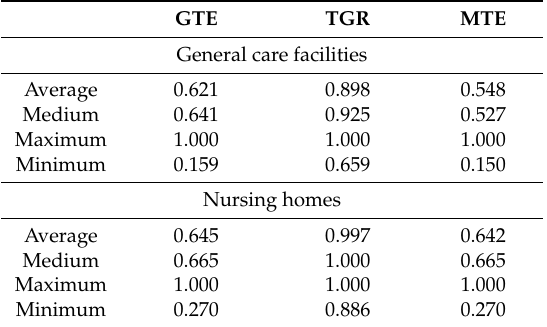
Table 8. Results of the metafrontier efficiency